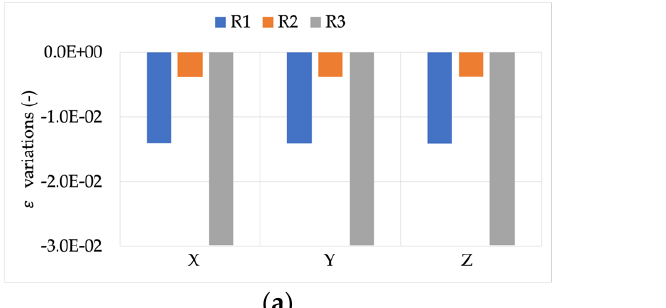
Figure 8. THD variations, compared to position L, obtained from measurements at the position M.